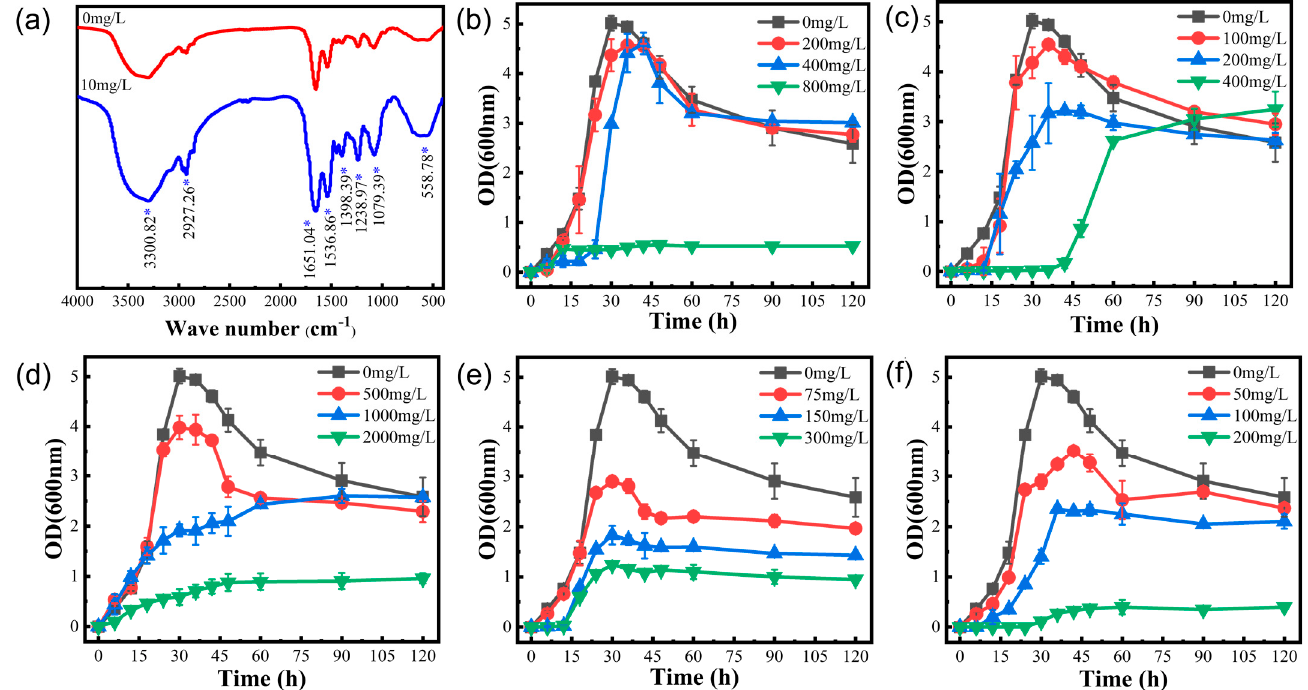
Figure 4. ( a ) FTIR spectra of the LBA 119 strain (* indicates peak increase). ( b ) Growth curves of LBA119 at different Mn 2+ concentrations. ( c ) Growth curves of LBA119 at different Zn 2+ concentra- tions. ( d ) Growth curves of LBA119 at different Pd 2+ concentrations. ( e ) Growth curves of LBA119 at different Cd 2+ concentrations. ( f ) Growth curves of LBA119 at different Cr 6+ concentrations.